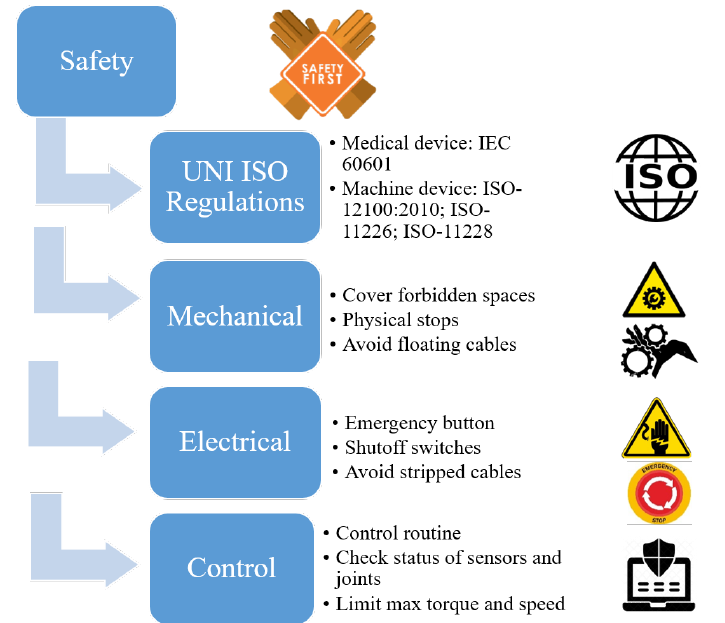
Figure 15. Safety requirements for wrist